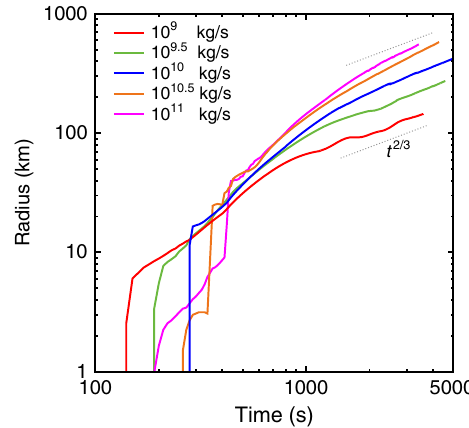
Fig. 4 Radii of the spreading umbrella clouds as a function of the time for the different simulations. Dashed lines correspond to the relationships between radius, R , and time, t : R t ð Þ ¼ At 2 = 3 , where A is the proportionality constant. This dependence is commonly used to estimate MFR 23,35,36 . The plot shows that with respect to the Plinian case, co-ignimbrite plumes with MFR > 10 10 kg/s have a steeper spreading rate, with the power-law exponent 23,35,36 passing from ~0.66 to 0.96. These results validate the robustness of simple box models for describing the umbrella region 35,36